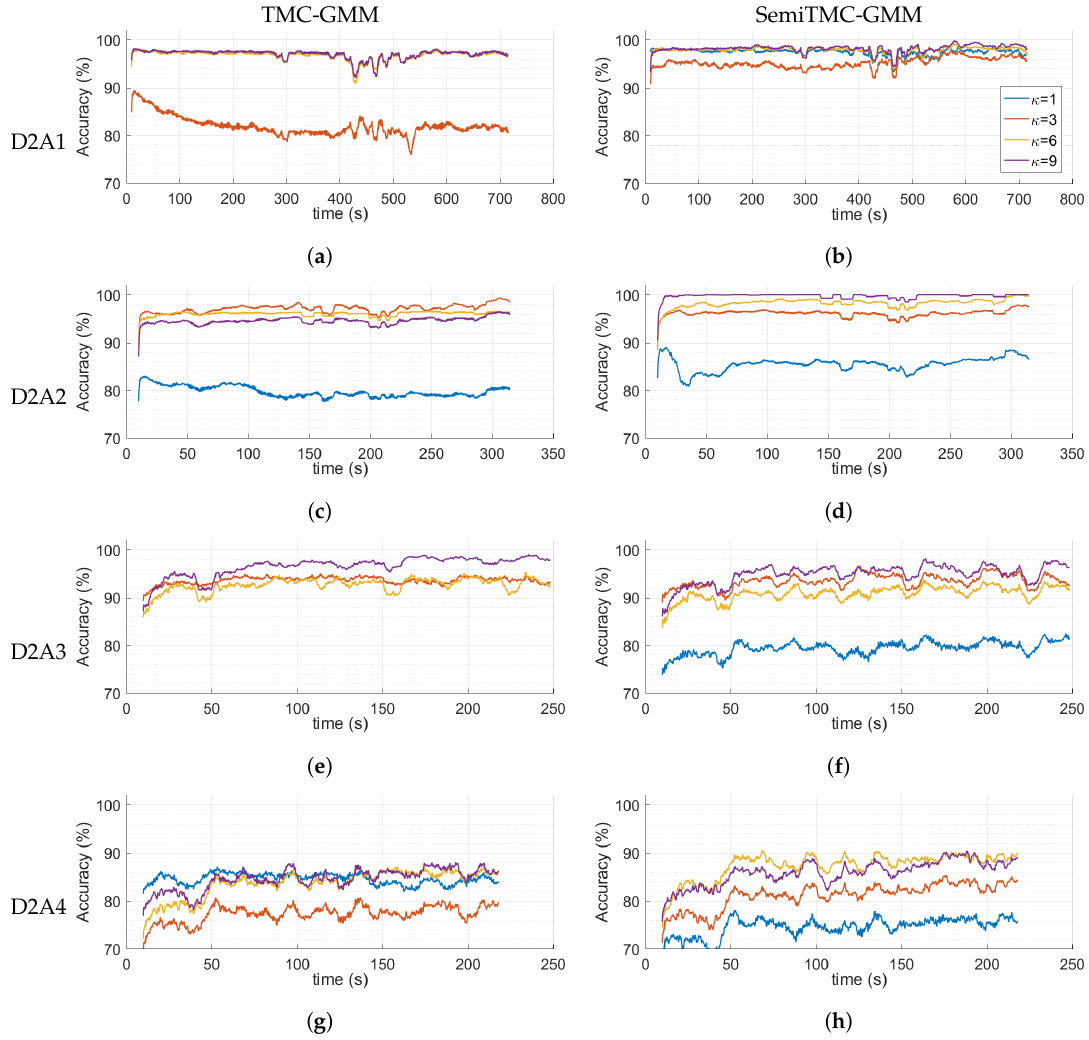
Figure 7. Recognition accuracy computed in the latest 10 s w.r.t. each activity of LMFIMU dataset. ( Left column ) TME-GMM; ( right column )